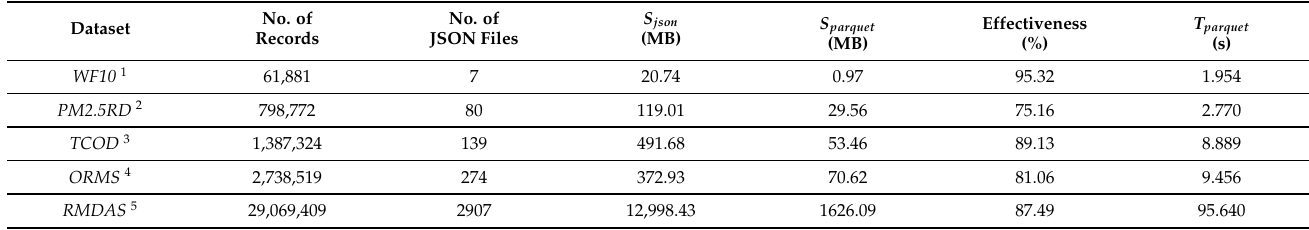
Table 4. Comparison of storage space consumption.